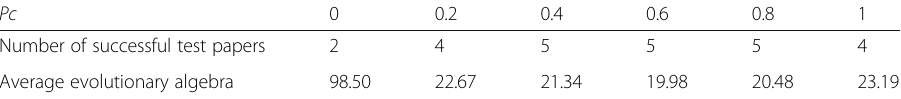
Table 4 The influence of parameter cross probability on the convergence of the algorithm Pc 0 Number of successful test papers Average evolutionary algebra